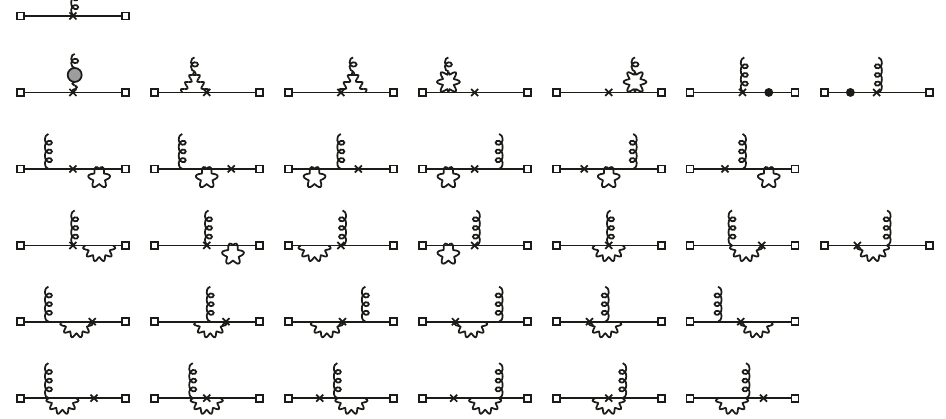
Figure 2 . The additional LO and NLO graphs contributing to the 3-point correlator in the non- relativistic description of section 5. The notation is the same as in figure 1. We note that in a thermal medium, gluon tadpoles give a finite contribution, proportional to T 2 , and must thus be